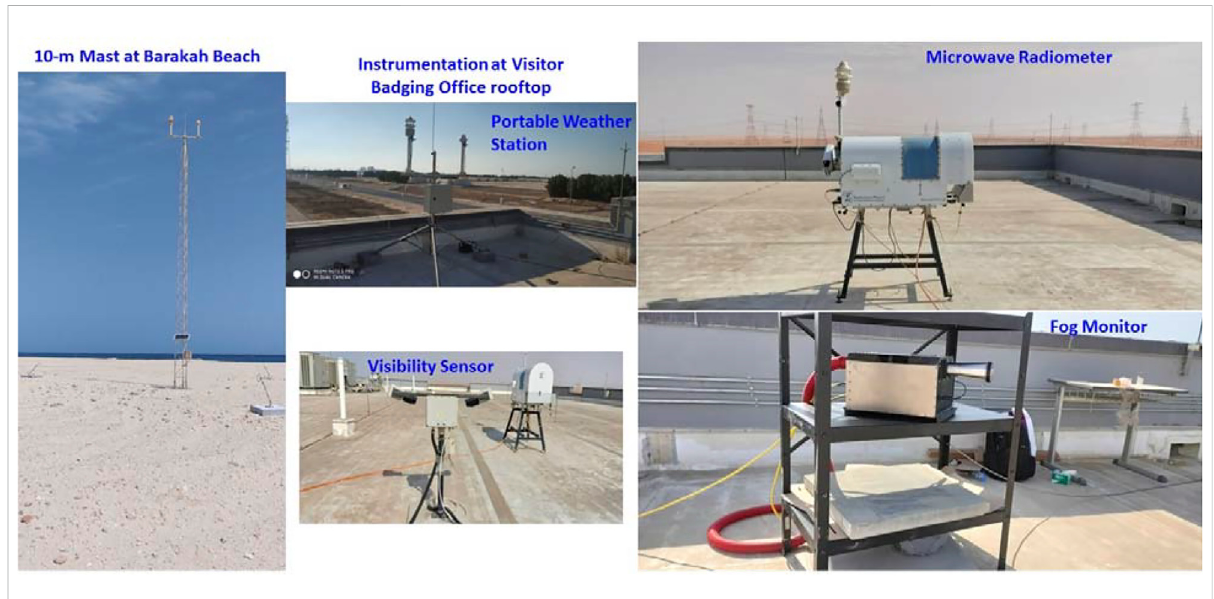
FIGURE 2 Overview of the instruments deployed at Barakah, United Arab